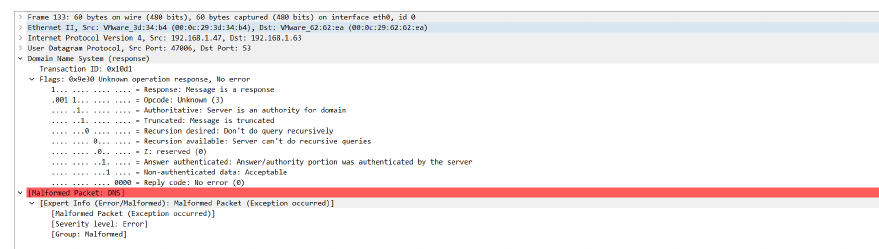
Figure A2. Sample packet generated from Dnsteal tunneling tool.